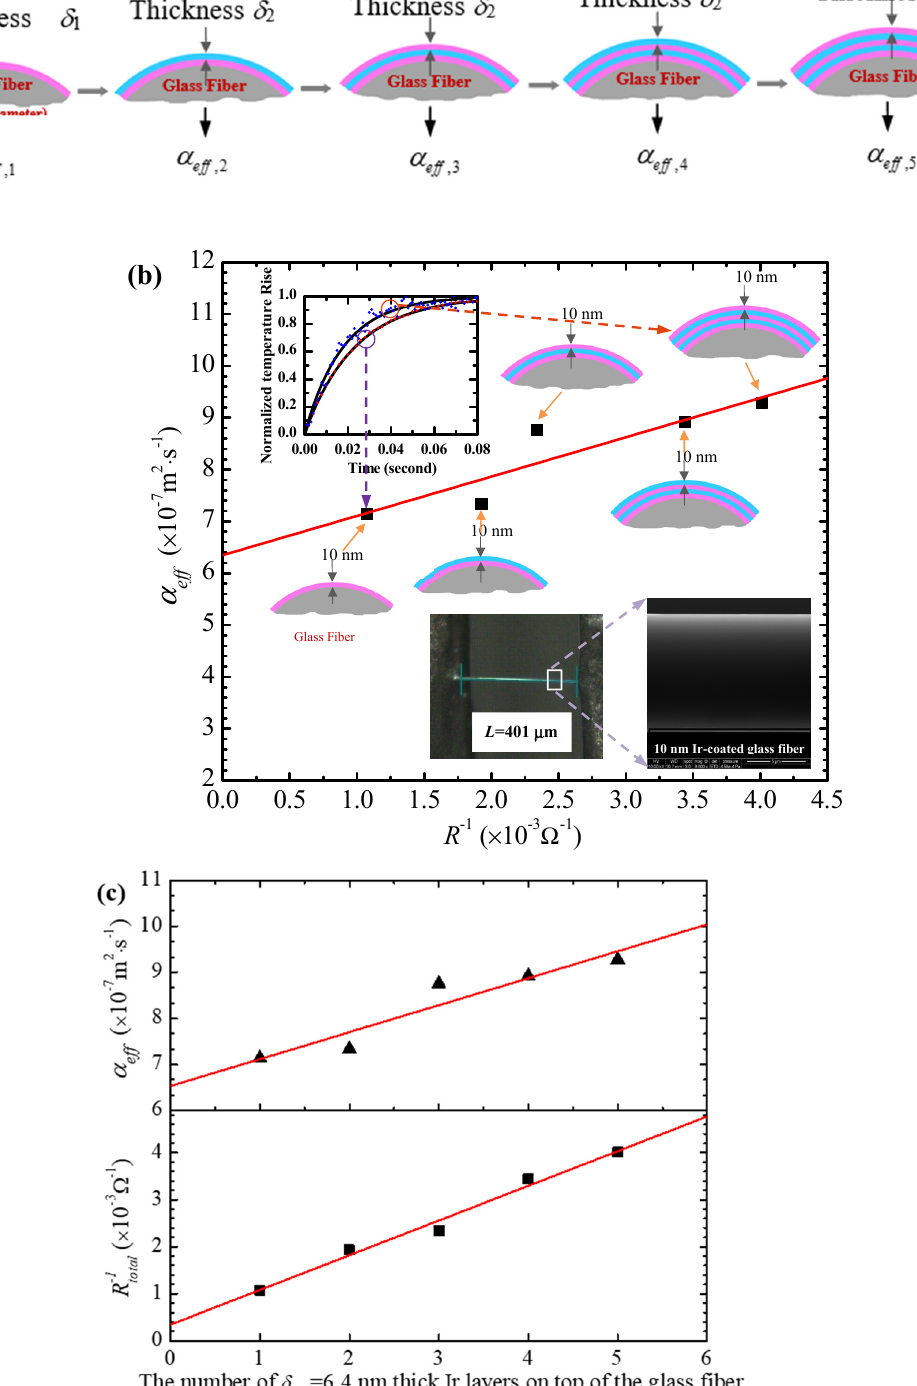
Figure 2. ( a ) Schematic cross-section of a substrate coated with different layers of nanofilms. The effective thermal diffusivity variation against the amount of metallic coating layers and electrical conductance (R − 1 ) used to obtain the Lorenz number, thermal conductivity, and electrical conductivity. ( b ) The effective thermal diffusivity versus the inverse electrical resistance of a substrate coated with 6.4 nm-thick Ir layers. ( c ) Linear fitting curves of the effective thermal diffusivity and resistance change with the number of Ir layers on the substrate. (Reprinted with permission from Ref. [56] Copyright John Wiley and Sons Small.).